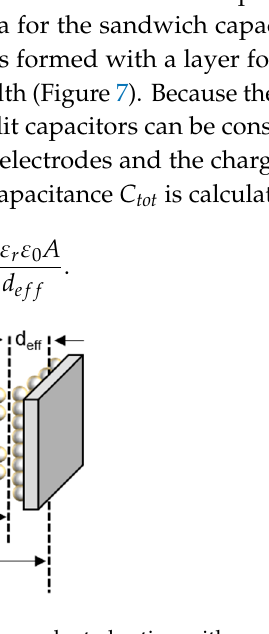
Figure 7. Schematic diagram of a capacitor formed by a solvated cation with a negative polarity located in the middle of two electrodes separated by a single layer of charge [39,44,50].